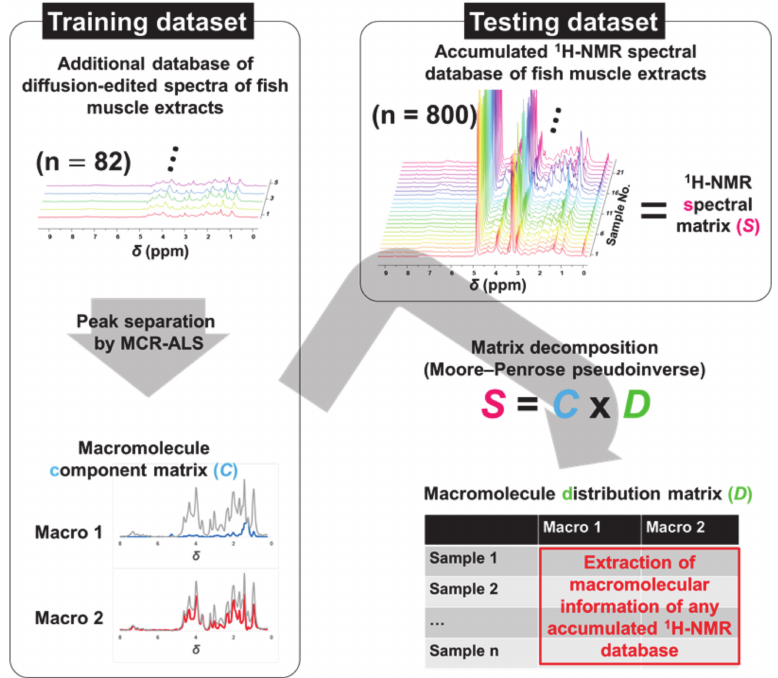
Figure 1. A schematic representation of the experimental